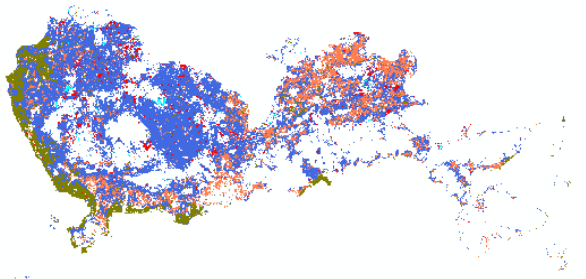
Figure 4: Overlay results of the city map show the urban expansion directions.